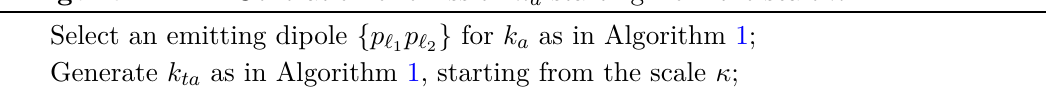
Algorithm 4.2: Generation of emission k